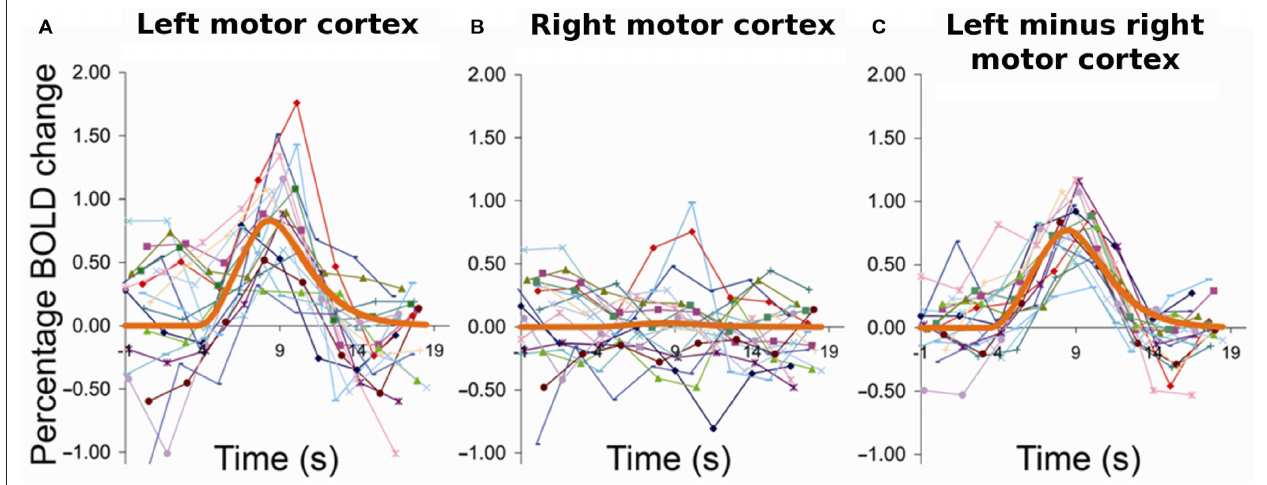
represents the respective best-fit gamma function. The event-related activity in left motor cortex showed high trial-to-trial variability. Strong variability was likewise observed in the spontaneous activity in the other, i.e., right hemisphere and could account for a major portion of variance of the left hemispheric evoked responses on a trial-by-trial basis. Reprinted from Fox et al. (2006a) with permission from Nature Publishing